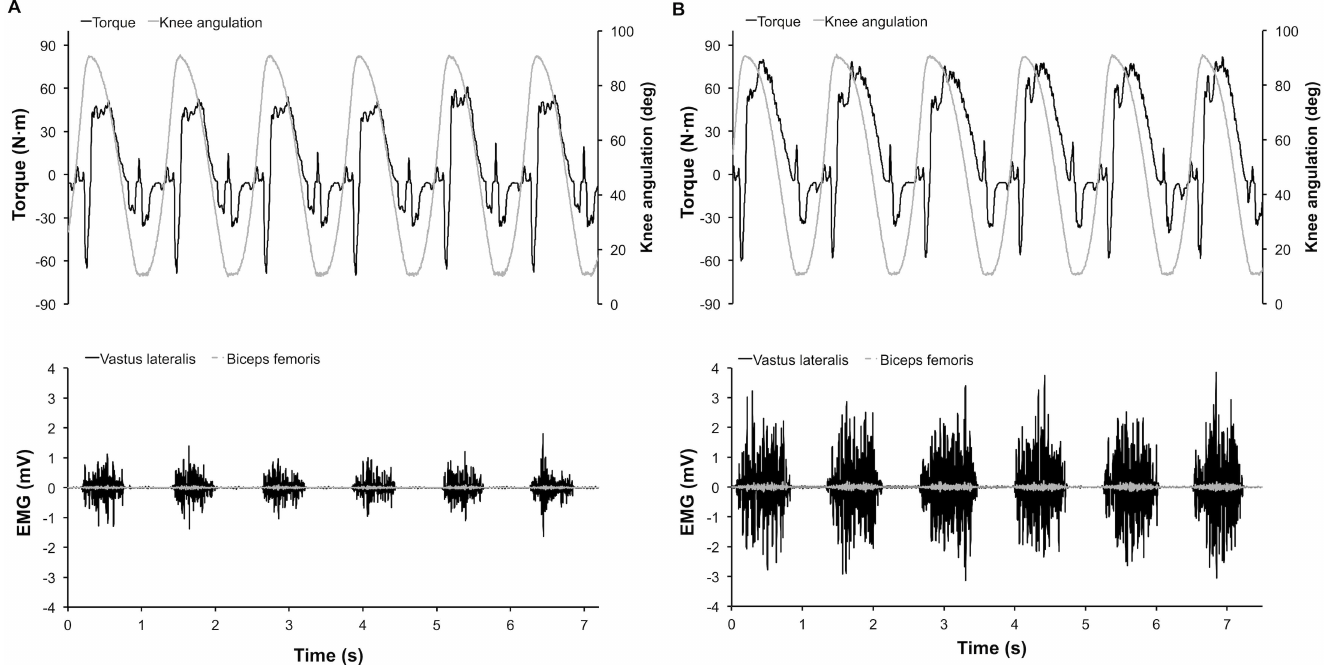
Fig 2. A typical recording of torque, knee angulation, Vastus Lateralis electromyography (EMG) and Biceps Femoris EMG during one leg dynamic exercisewith isotonic resistance at 9 N (cid:1) m (~ 16.7 W, panel A) and 37 N (cid:1) m (~ 68.5 W, panel